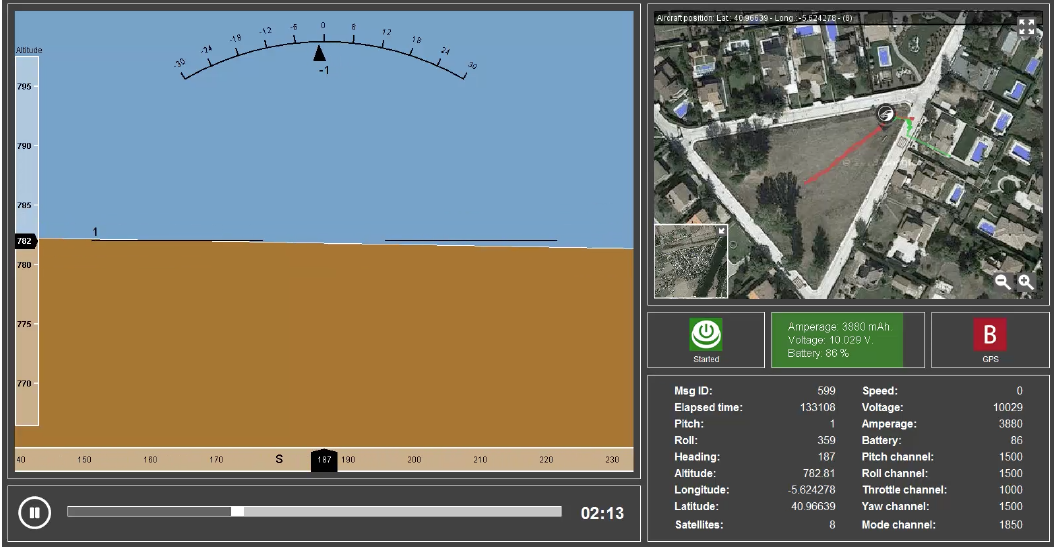
Figure 3. Software developed to visualize the telemetry